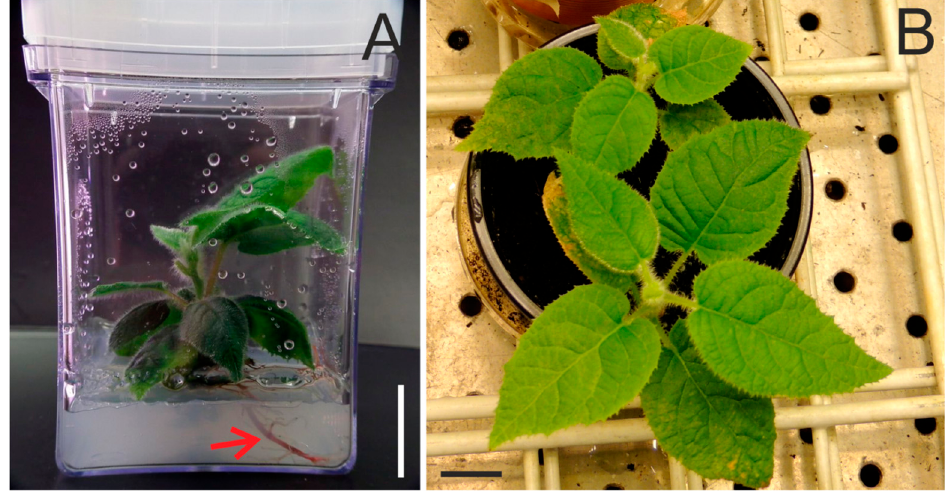
Figure 1. Rooting and acclimatization of the Actinidia chinensis var. deliciosa plants to ex vitro conditions. ( A ) Plants regenerated from endosperm-derived callus and transferred onto half-strength MS medium in Magenta vessels; visible well-developed roots (arrow). ( B ) Acclimated plants. Bars = 2 cm.